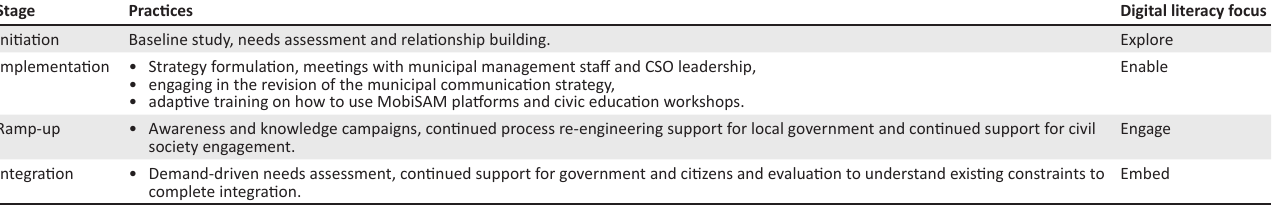
TABLE 2: A summary of the knowledge transfer process of digital literacy development. Baseline study, needs assessment and relationship